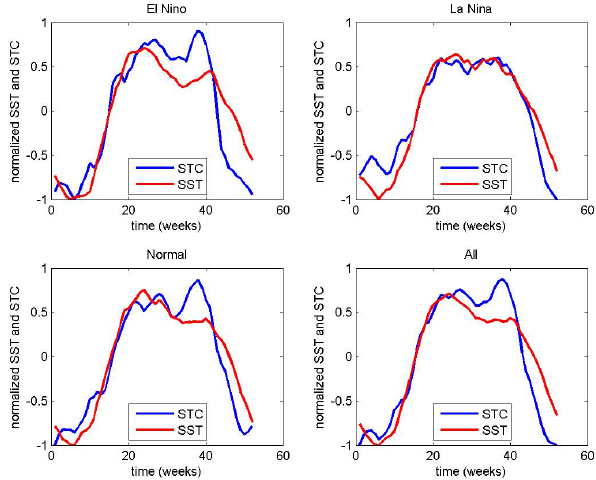
Fig. 9. The STC and SST yearly average values (as computed in Fig. 8) were mean-centered and divided by the maximum value. For El Ni ˜ no and La Ni ˜ na, all strong, moderate and weak years were